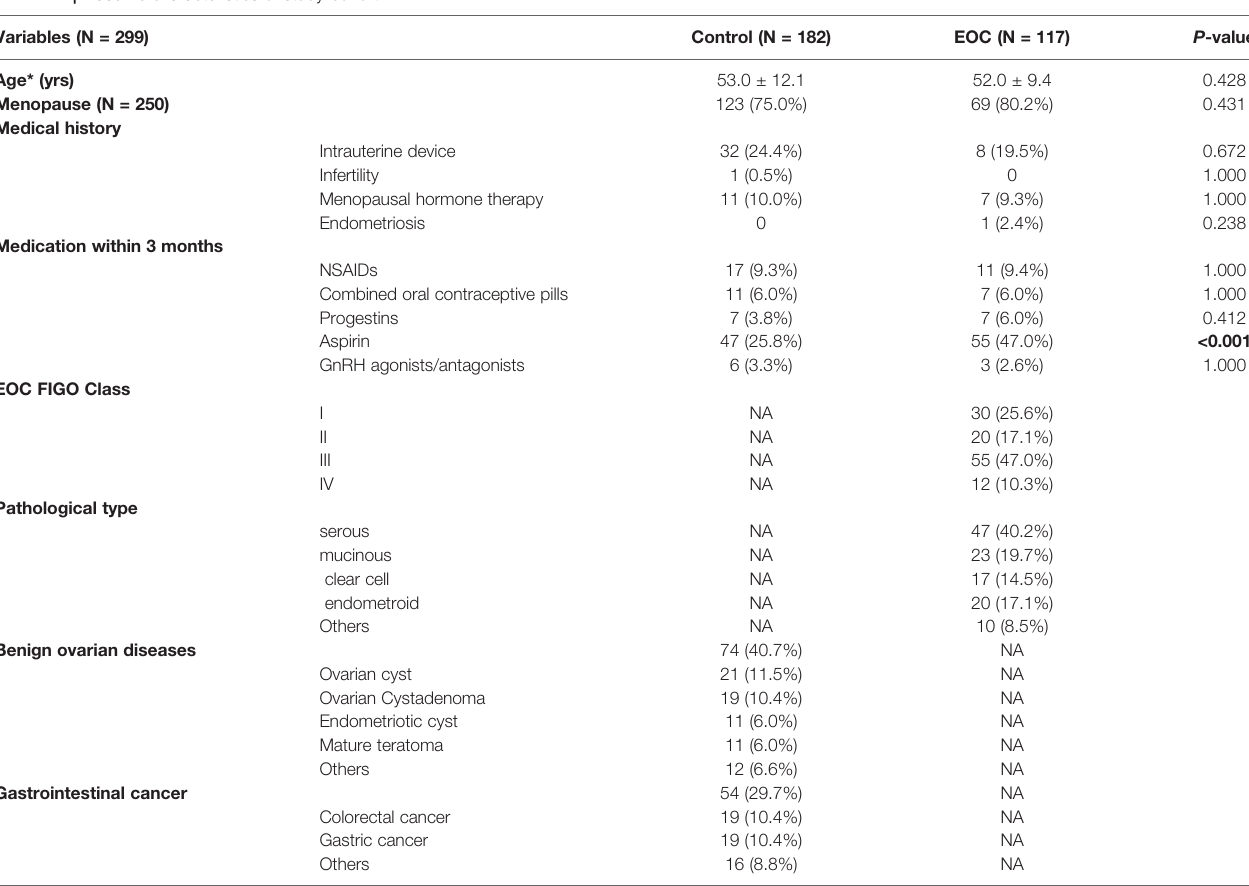
TABLE 1 | Baseline characteristics of